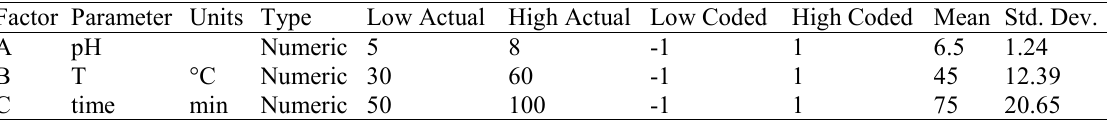
Table 1. The range and levels of the independent variables Factor Parameter Units